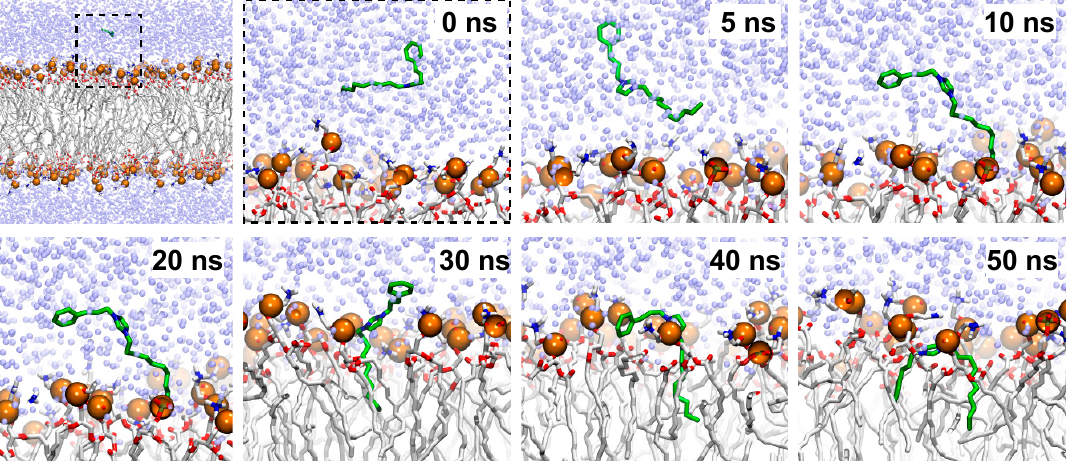
Figure 5. Incorporation of [CDIM]Cl into the membrane along with the 50 ns MDs.